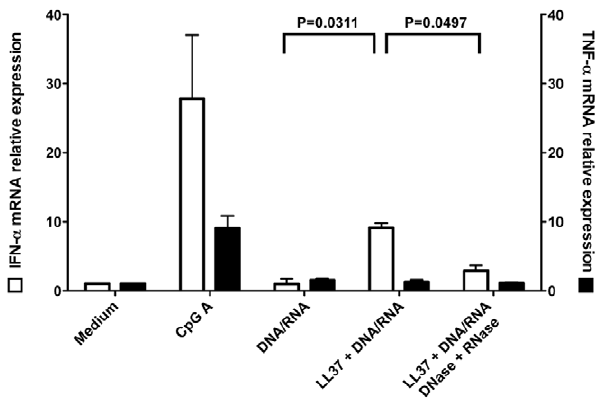
Figure 6. LL-37 upregulates the expression of IFN- a , but not TNF- a in thymic pDC. Sorted pDC were incubated with LL-37 plus or minus eukaryotic DNA/RNA or LL-37-DNA/RNA complex pretreated with DNAse and RNAse. CpG-A 2216 was used as a positive control. Q-PCR was performed for IFN- a and TNF- a mRNA.